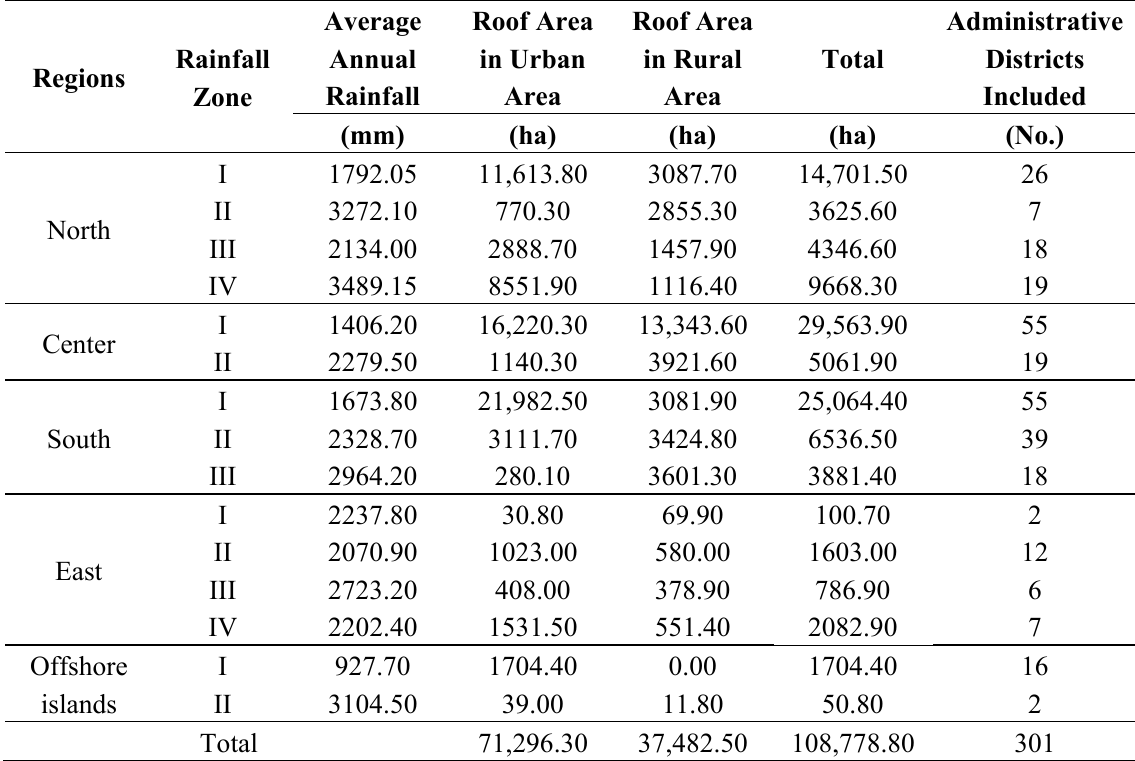
Table 3. Average annual rainfall, roof area in urban and rural areas, and administrative districts included in different regions and rainfall